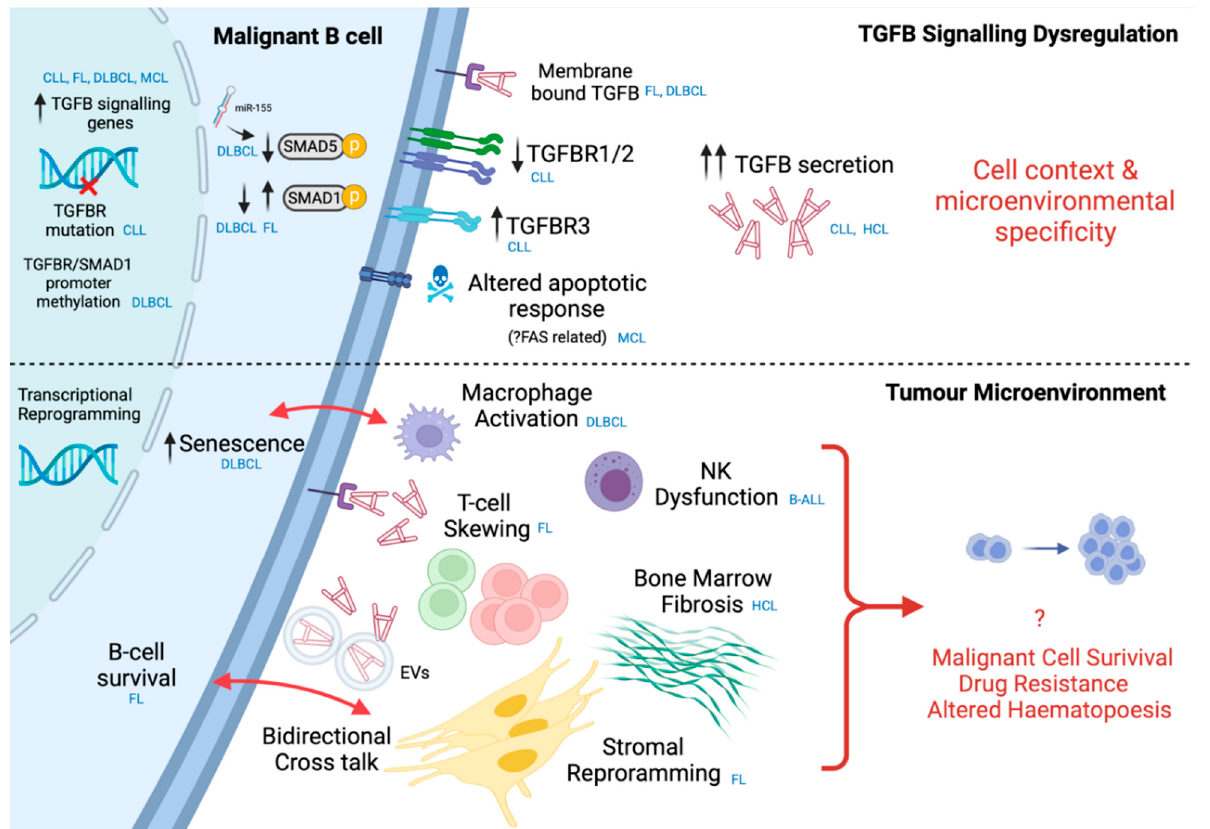
Figure 4. Overview of intrinsic and extrinsic TGFB signalling alterations in B-cell malignancies. Upper panel: Intrinsic signalling alterations in B-cell malignancies ranging from receptor dysfunction, SMAD signalling alterations, and genetic and epigenetic alterations. Distinct alterations are observed depending on the histological subtype defined in blue and are likely dependent on the microenvironmental context. Lower panel: Extrinsic effects of microenvironmental TGFB on B-cell tumour microenvironment. TGFB predominantly promotes a prosurvival niche mediated by immune suppression and stromal reprogramming. Complex bidirectional cross-talk between cells of the microenvironment (stroma and macrophages) drives senescence and survival in malignant B-cells. Alterations observed are dependent on the histological subtype defined in blue. Overall, intrinsic resistance to TGFB and TGFB mediated protumour microenvironmental reprogramming may drive malignant cell survival, drug resistance, and disturbed haematopoiesis. CLL: chronic lymphocytic leukaemia, DLBCL: diffuse large B-cell lymphoma, FL: follicular lymphoma, MCL: mantel cell lymphoma, B-ALL: B-cell acute lymphoblastic lymphoma. Figure generated using Biorender.com (accessed 28 February